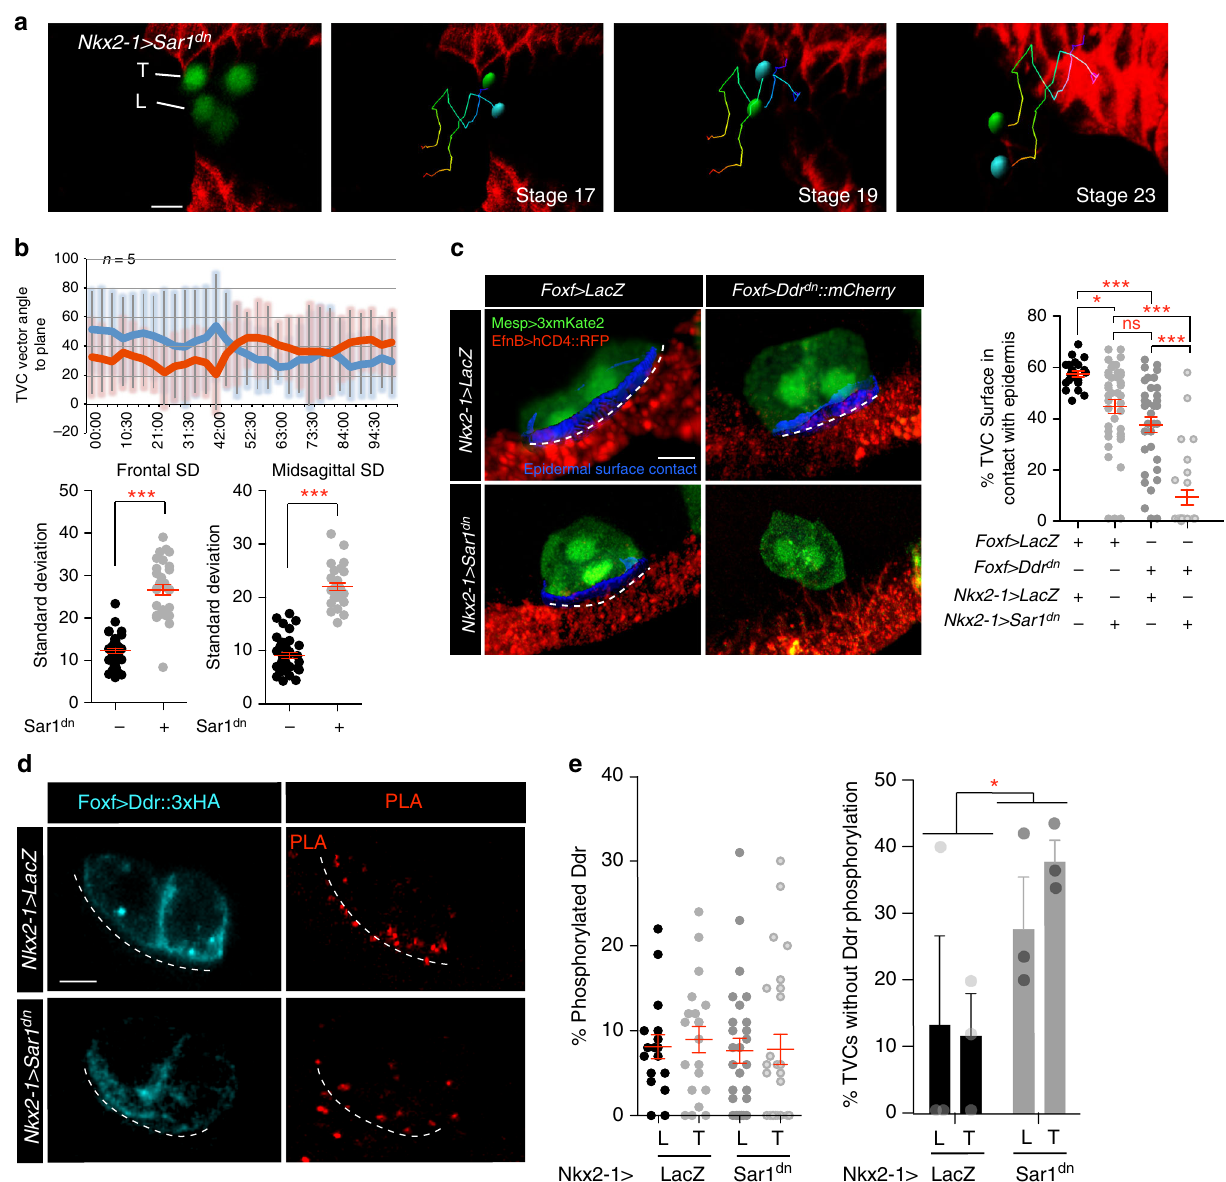
Fig. 3 An endodermal cue potentiates TVC adhesion and Ddr activation. a Positional tracking of TVC migration in embryos expressing endodermal Nkx2 – 1 > Sar1 dn to block secretion. Tracks are time coded from early (blue) to late (red). Leader = cyan, trailer = green. Scale bar = 20um. b Quantitation of migration angles to frontal and sagittal planes is shown as averages at each time point and standard deviation from average. Statistical signi fi cance established using the Wilcoxon Rank Sum test. S.E.M is shown. c Percent of TVC-pair surface in contact with epidermis. The B7.5 lineage is marked with Mesp> 3xmKate2 , epidermis is marked with EfnB > hCD4::RFP . Surface of contact is shown in blue and marked with a dashed line. Scatter plot shows average surface contact under each condition. Statistical analysis using one-way ANOVA followed by the Bonferroni post hoc test. S.E.M is shown. Scale bar = 10 μ m. d PLA of Foxf > Ddr::3xHA under control ( Nkx2 – 1 > LacZ ) and Nkx2 – 1 > Sar1 dn conditions. Dotted line marks the ventral surface of TVCs. Scale bar = 10 μ m. e Scatter plot on the left shows percent phosphorylated Ddr. S.E.M. is shown. Bar graph on the right shows the average percent of TVCs with no detectable Ddr phosphorylation. For c and d data are pooled from three biological replicates. All images are oriented with leader TVC to the left. * p